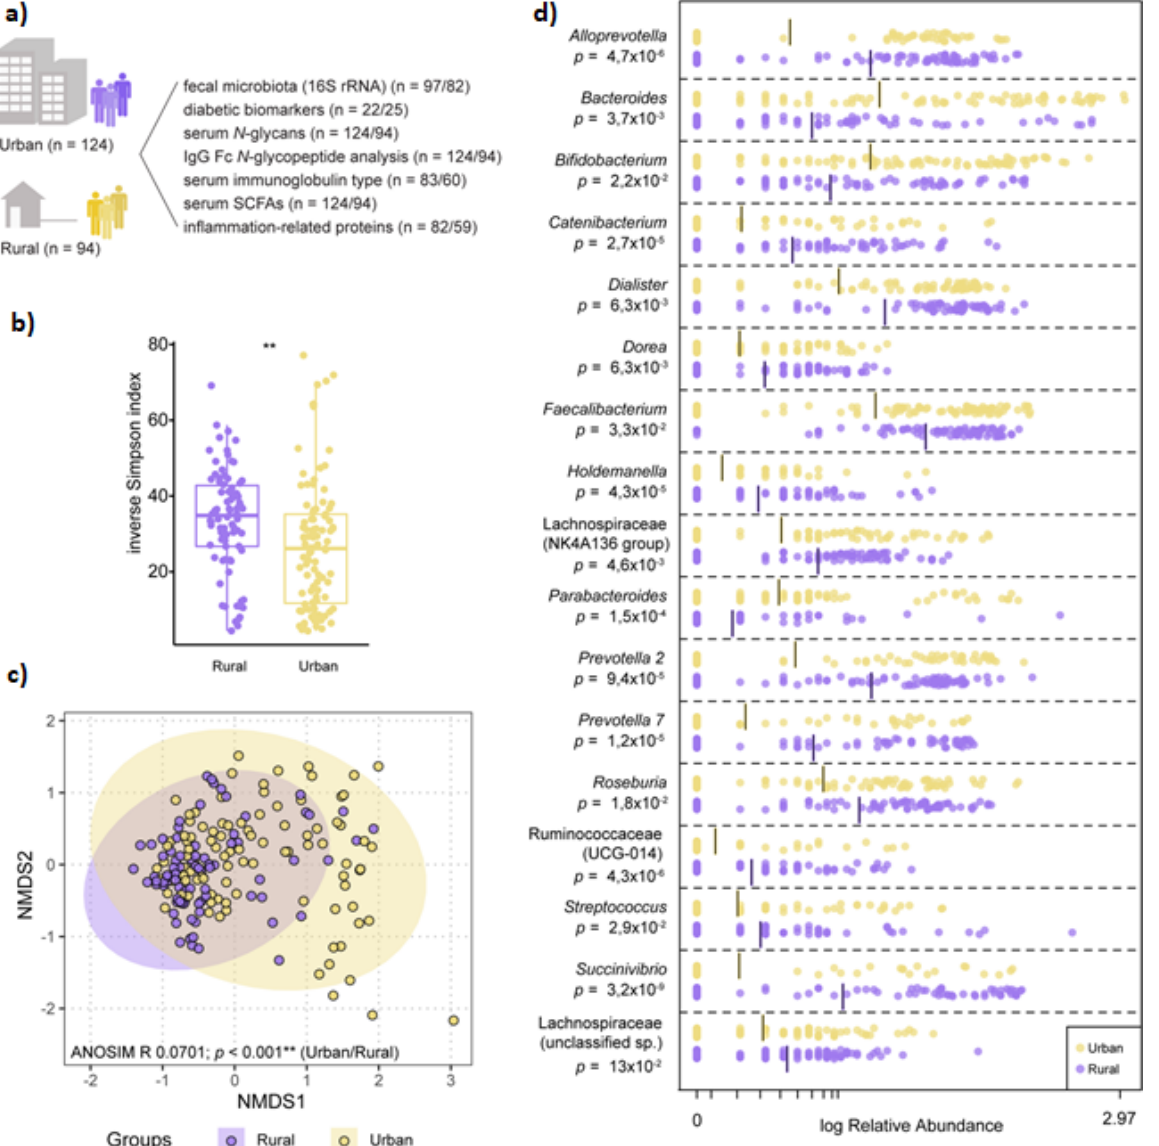
Figure 1. The microbiota is structurally distinct in participants from rural vs. urban areas. ( a ) Schematic of overall study design ( n = number of urban/rural samples). ( b ) Diversity as determined by inverse Simpson index based on normalized ASV counts in participants from rural vs. urban areas (Kruskall–Wallis nonparametric test, p < 0.001). ( c ) Non-metric multidimensional scaling (NMDS) visualization of Bray–Curtis distance (based on normalized ASV counts) of the microbiota in participants based on geography (rural vs. urban; purple vs. yellow). Analysis of similarities (ANOSIM) was conducted using Bray–Curtis distance, 9999 permutations. ( d ) Log-transformed relative abundance of significantly differential genera between participants from rural or urban areas, as determined by Linear discriminant analysis Effect Size (LEfSe).